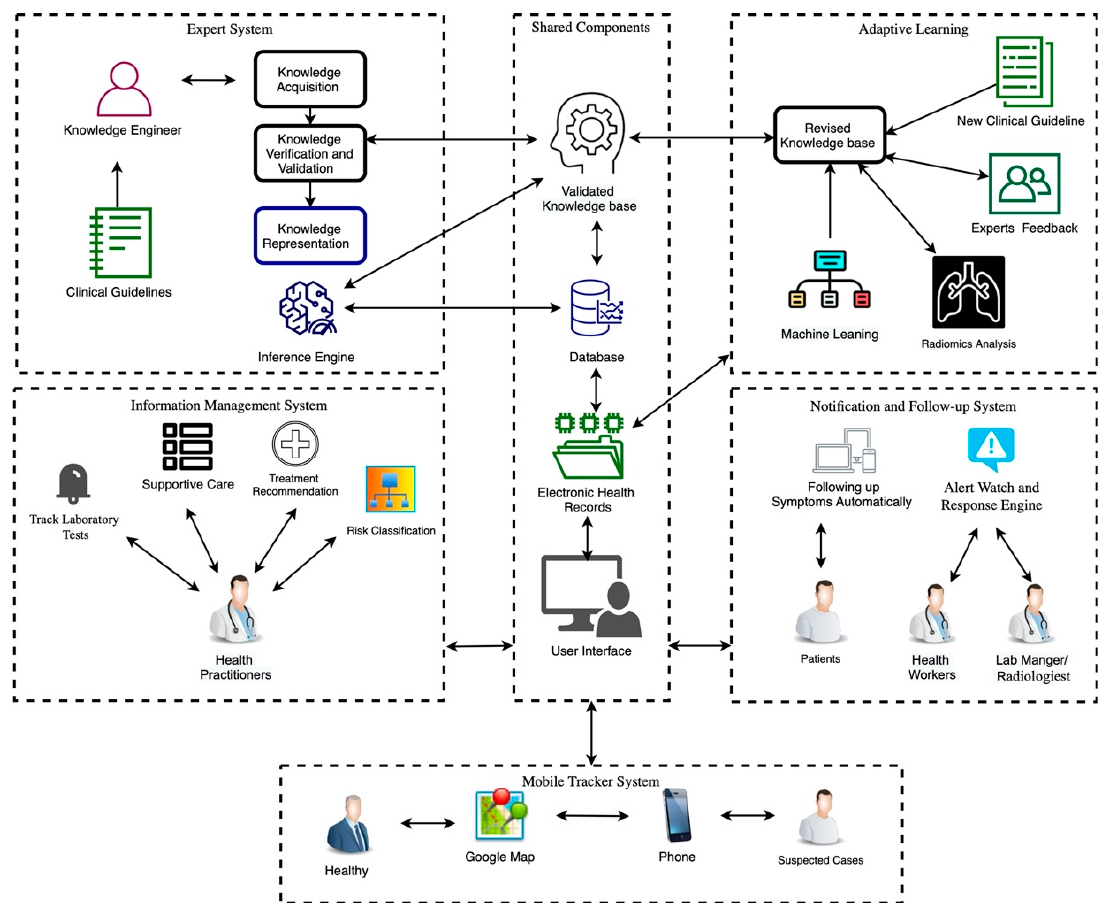
Figure 1. The system architecture. The framework includes five sub-systems. (i) The information management system includes laboratory tests, supportive care, treatment recommendations, and risk classifications. The health practitioners can request information from the database and the expert